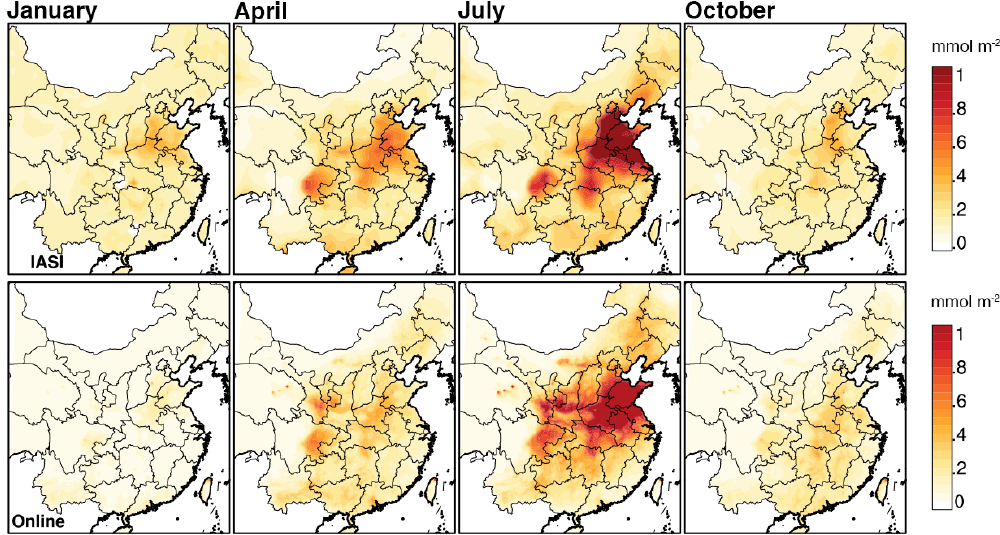
Figure 7. Comparison of column NH 3 concentrations between IASI satellite retrievals (upper row) and WRF–Chem online (lower row), averaged for January, April, July and October